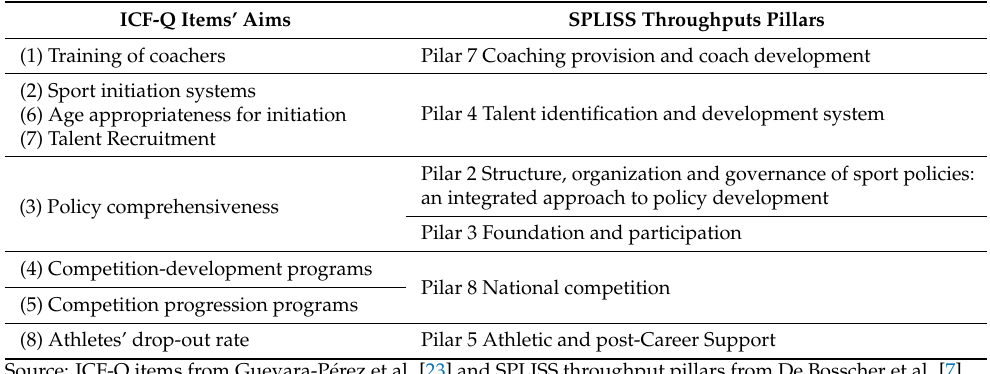
Table 2. Correspondences between ICF-Q items’ aims and SPLISS throughputs